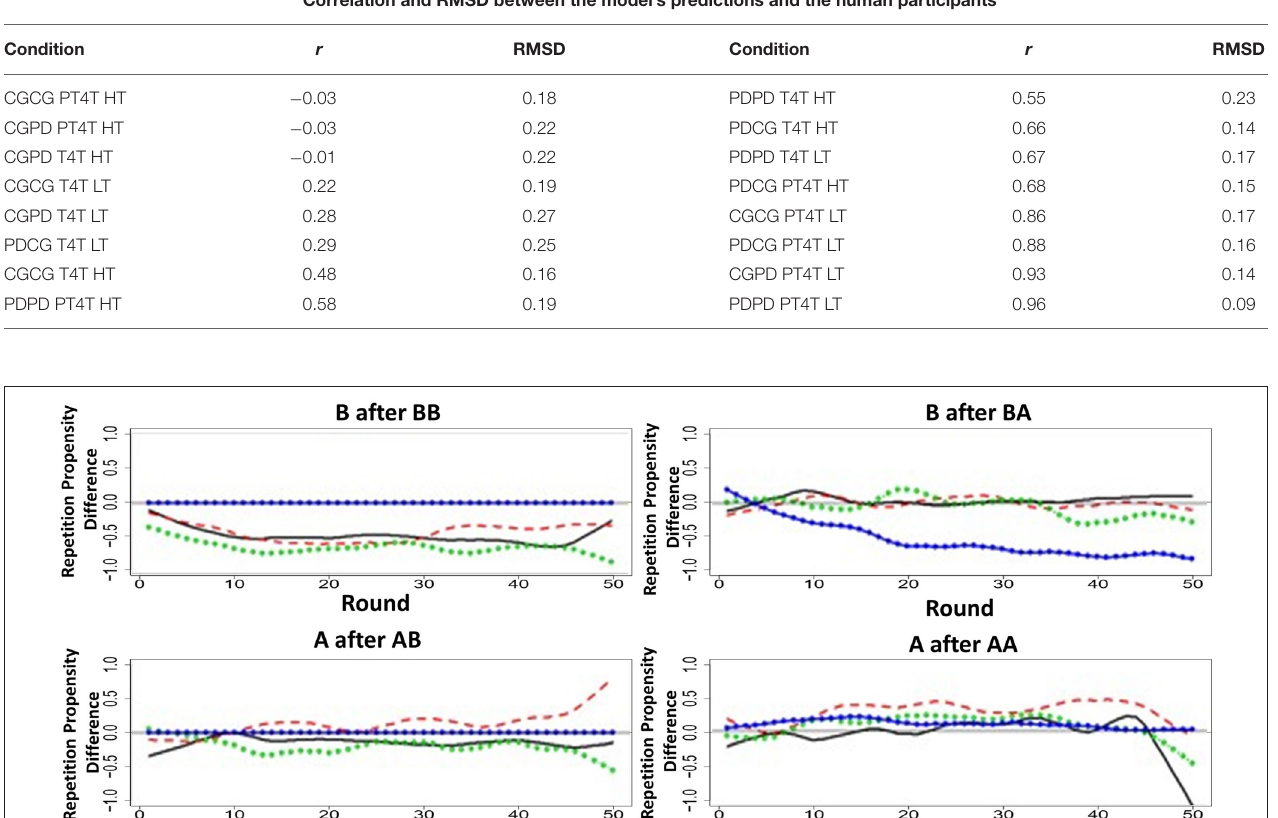
TABLE 5 | Correlation ( r ) and root mean squared deviation (RMSD) between the model’s predictions and the human behavior in each condition, averaged across all five outcomes. Correlation and RMSD between the model’s predictions and the human participants Condition